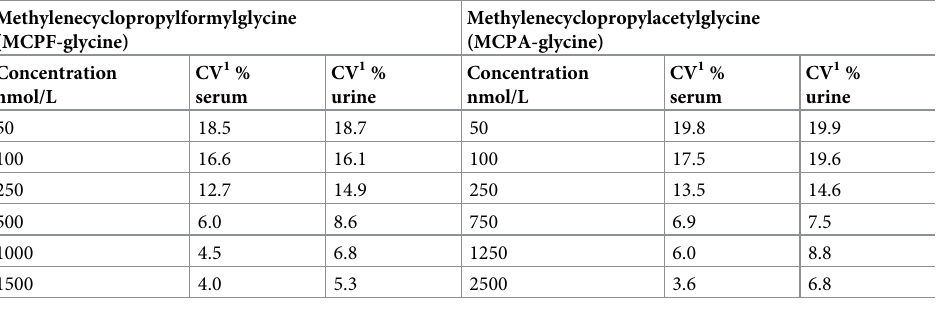
Table 2. Precision of MCPF-glycine and MCPA-glycine quantification: Coefficients of variation for MCPF-gly- cine and MCPA-glycine measurements found for 6 concentration